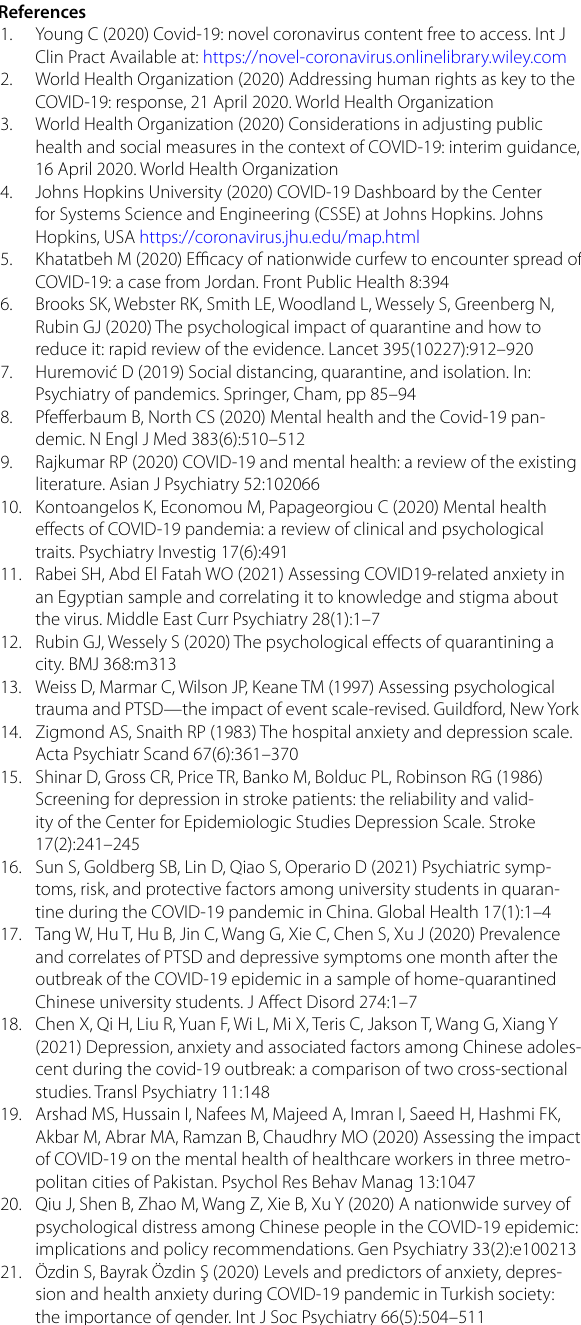
Table 5 Predictors of depression among respondents after the first wave of COVID‑19